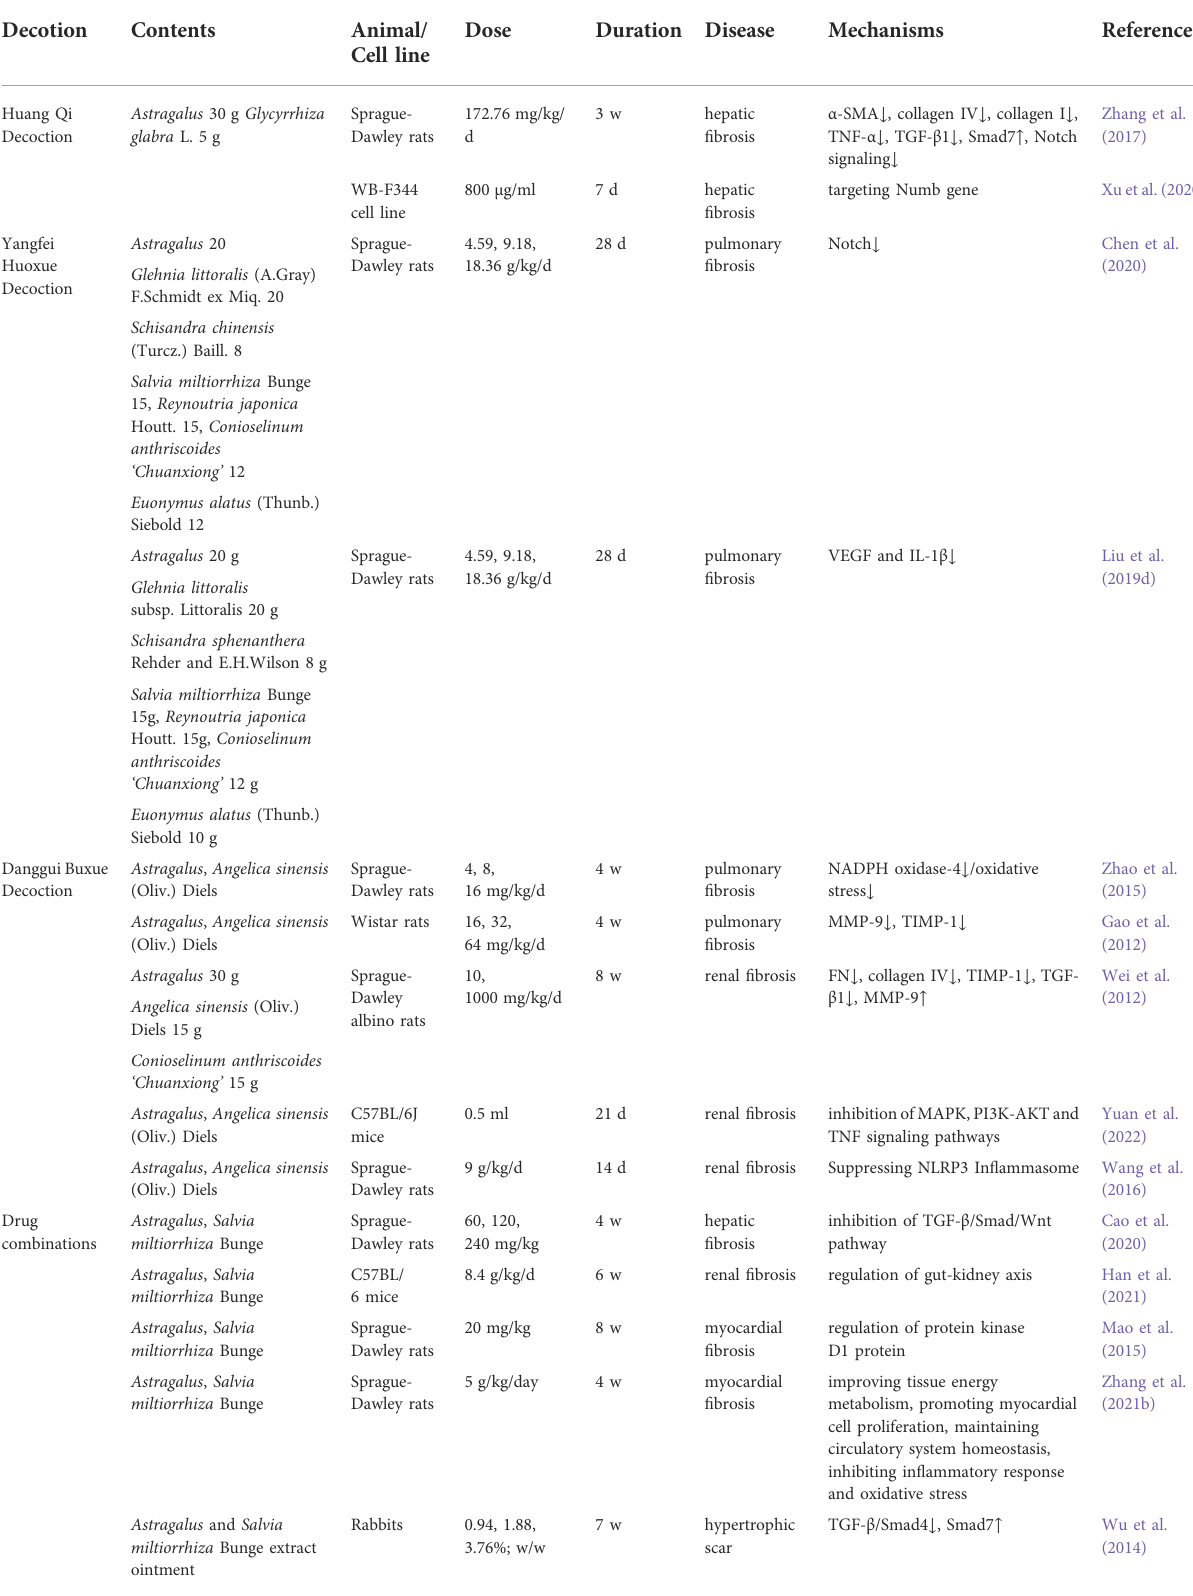
TABLE 2 Effect of herbal formulas containing Astragalus on fi brotic diseases.